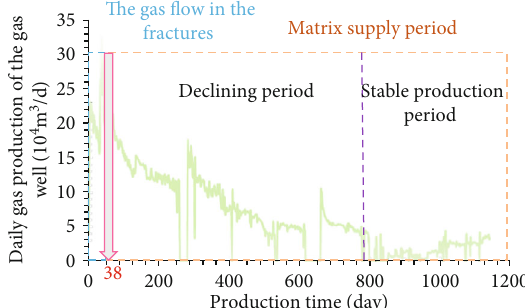
Figure 8: The daily gas production and production time of the gas well